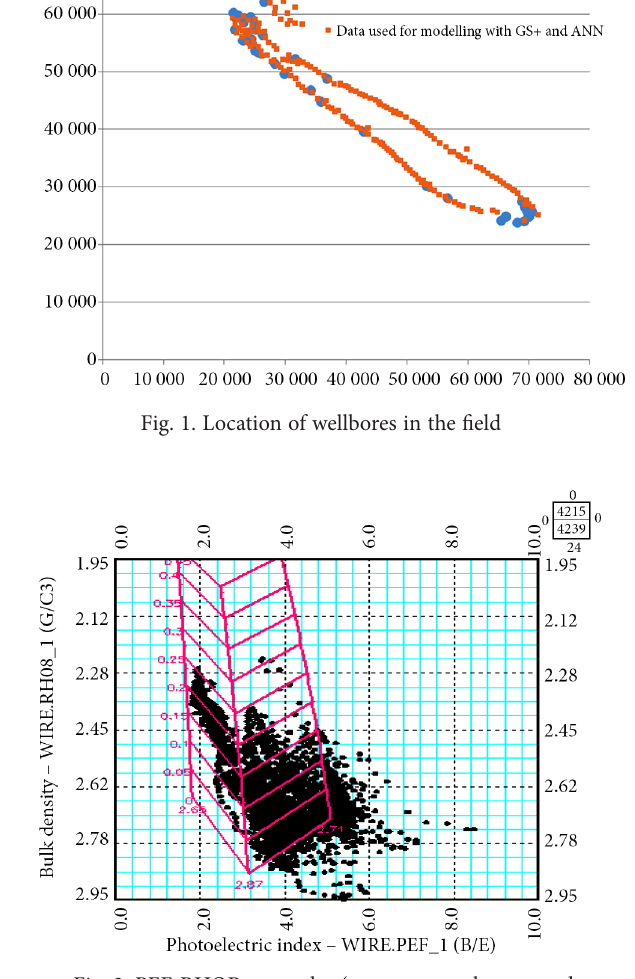
Fig. 2. PEF-RHOB cross plot (represents carbonate and sandstone